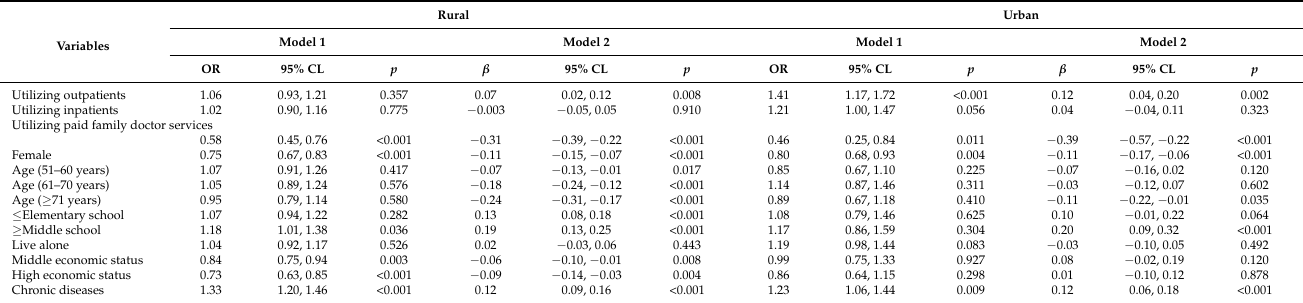
Table 5. Determinants of dissatisfaction with local medical services by multilevel mixed-effect models.